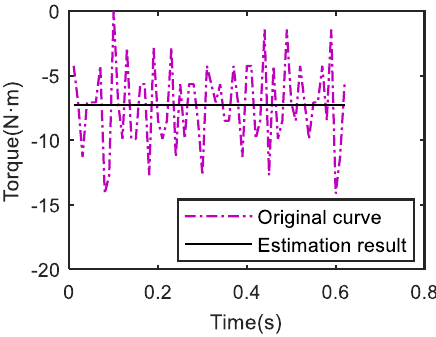
Figure 11. Comparison between AMT input shaft’s angular acceleration and estimation without TB